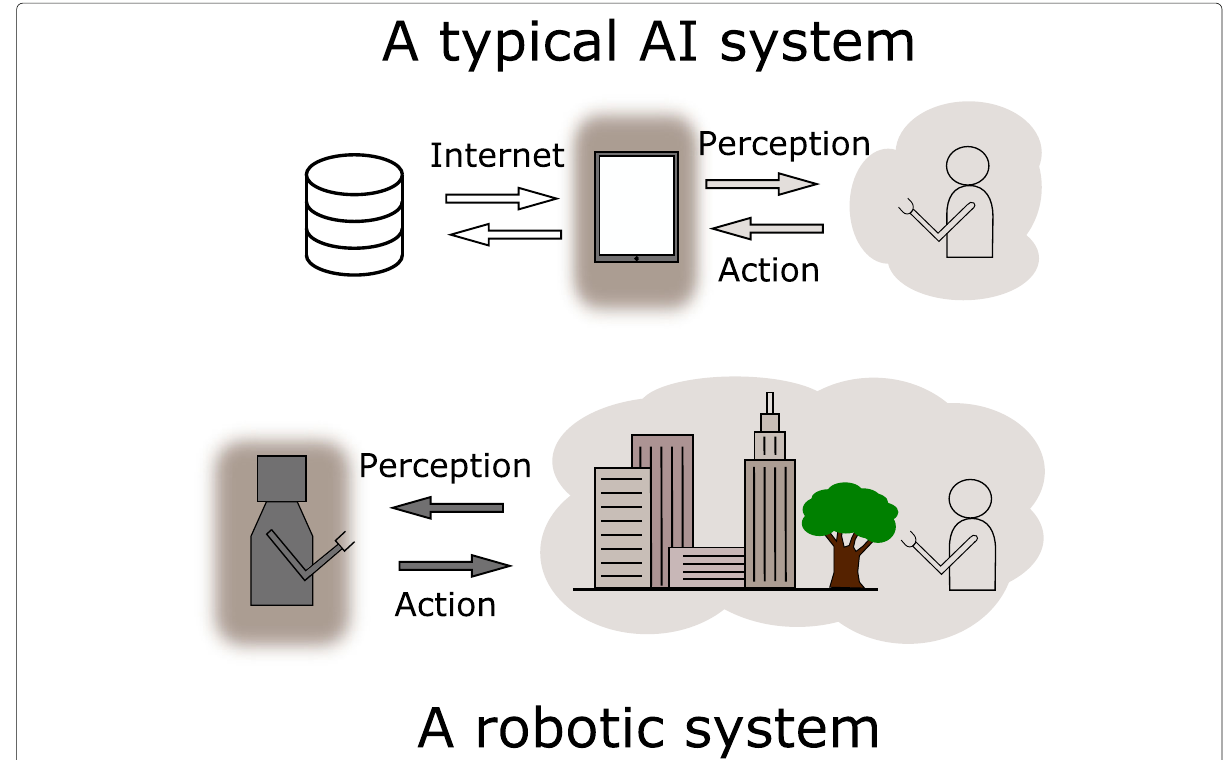
Fig. 1 A typical AI system interacts with a human user (search engine, recommendation tool, translation engine ...). The human user launches the request and the result is intended to be perceived by him or her and there is in general no other connection to the real world. The system is thus not active in the real world, only the human is. A robotic system is active. It directly interacts with its environment through its perceptions and actions. Humans may be part of the environment, but otherwise are not involved in robot control loop, at least for autonomous